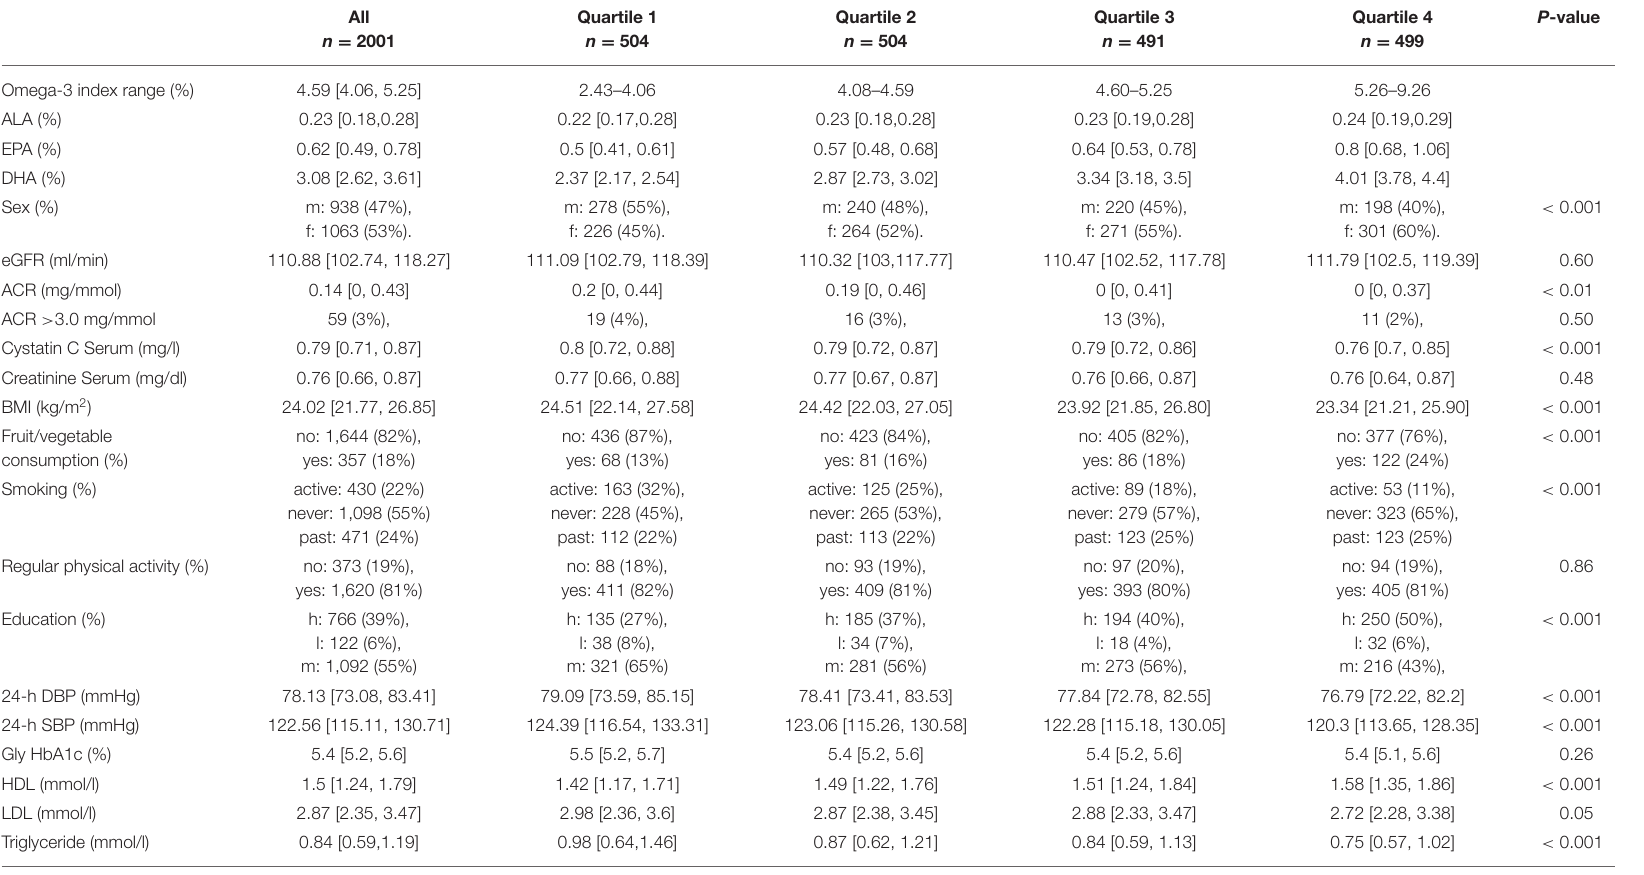
TABLE 1 | Baseline characteristics.